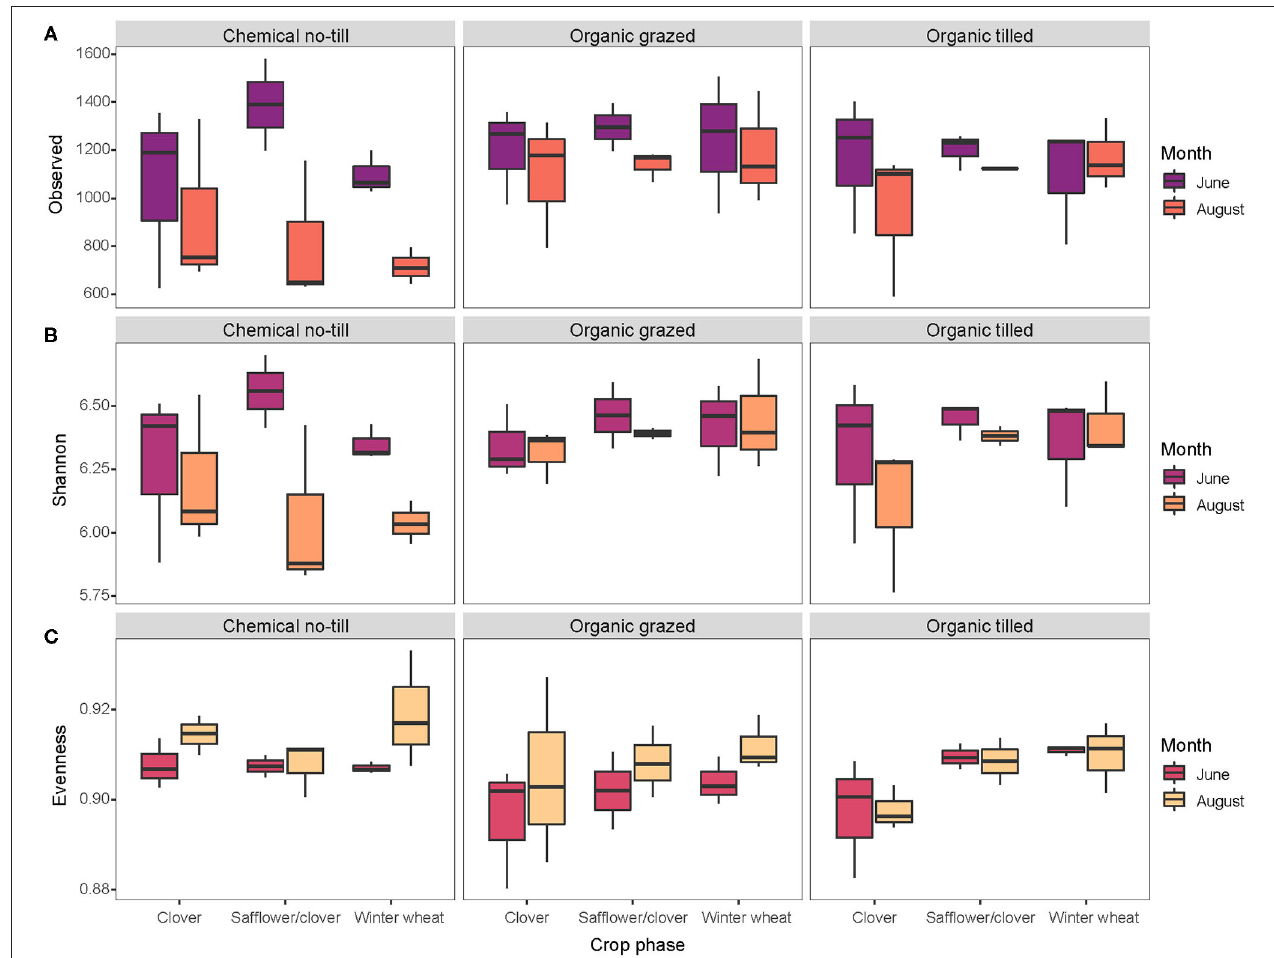
FIGURE 1 | Alpha diversity metrics for soil bacterial communities associated with three crops in three contrasting dryland cropping systems in June and August. Diversity metrics include (A) richness, (B) Shannon’s Diversity, and (C) Shannon’s Evenness.